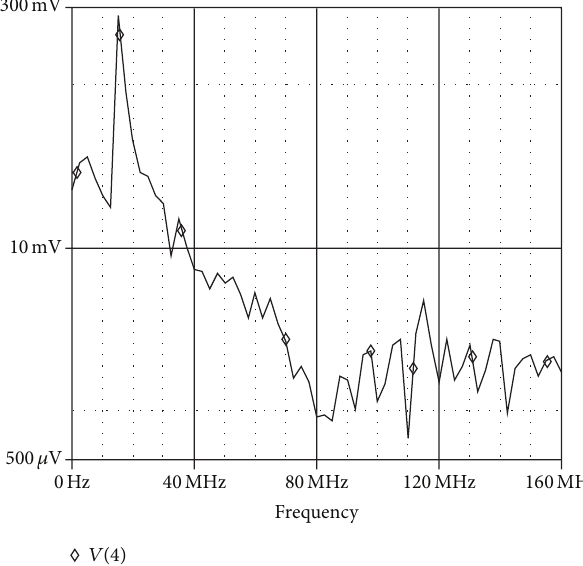
Figure 8: Fourier spectrum of output waveform at 15.92MHz.